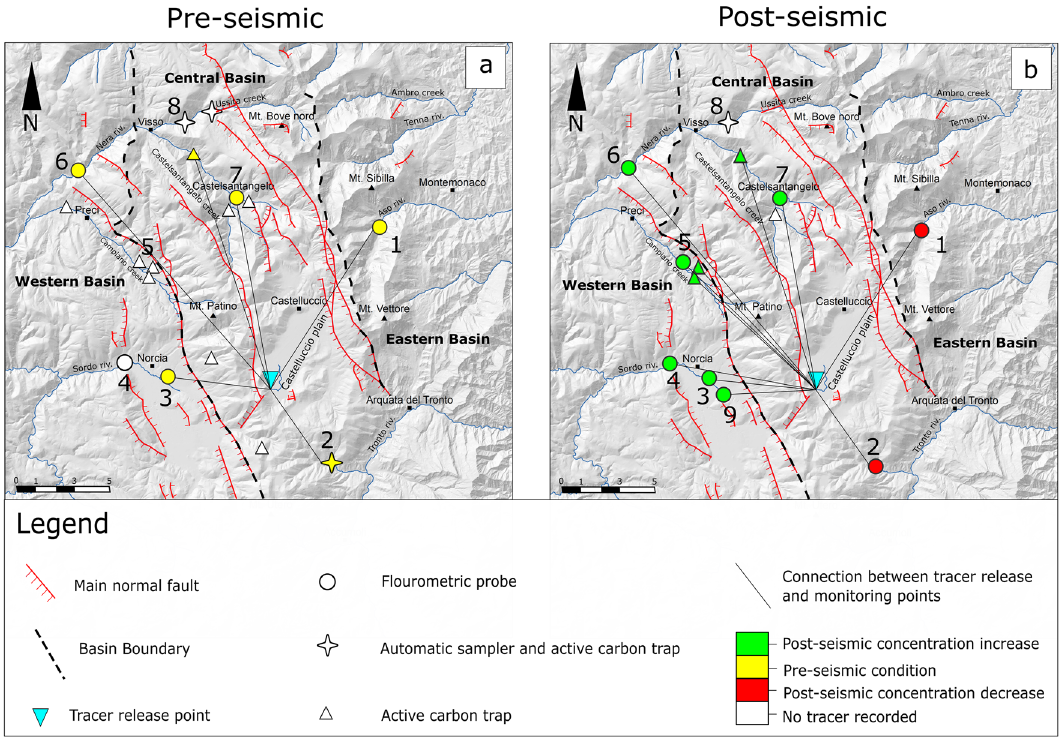
Figure 4. Tracer test results. The base map was obtained by elaborating the digital elevation model (DEM) from the TINITALY/01 DEM of the whole Italian territory (https:// tinit aly. pi. ingv. it/; Tarquini et al. 41 ; CC BY 4.0 License, http:// creat iveco mmons. org/ licen ses/ by/4. 0/), by means of the Open Source package QGIs v 3.16 (https:// www. qgis. org/ en/ site/). The map has been then edited with the Open Source software Inkscape v.1.2.1 (https:// inksc ape. org/ about/ licen se/). ( a ) Distribution of tracer arrival at the sampling points before the seismic crisis. The yellow symbols indicate that tracer was detected. White symbols indicate that no tracer was detected. All numbered sampling points, but point 5, roughly correspond to water discharge measure points as follows: 1 = FoS; 2 = CqS; 3 = SmS/PrS; 4 ~ SoR; 6 downstream of UsNeR; 7 = NeR1; 8 = UsR; 9 = ToS. ( b ) Distribution of tracer arrival at the sampling points after the seismic crisis. The green symbols indicate that tracer was detected with increased concentration with respect to pre-seismic conditions. The red symbols indicate that tracer was detected with decreased concentration with respect to pre-seismic conditions. Connections between tracer release and monitoring point are not meant as actual pathways to the sampling sites but as an evidence of an existing link between the